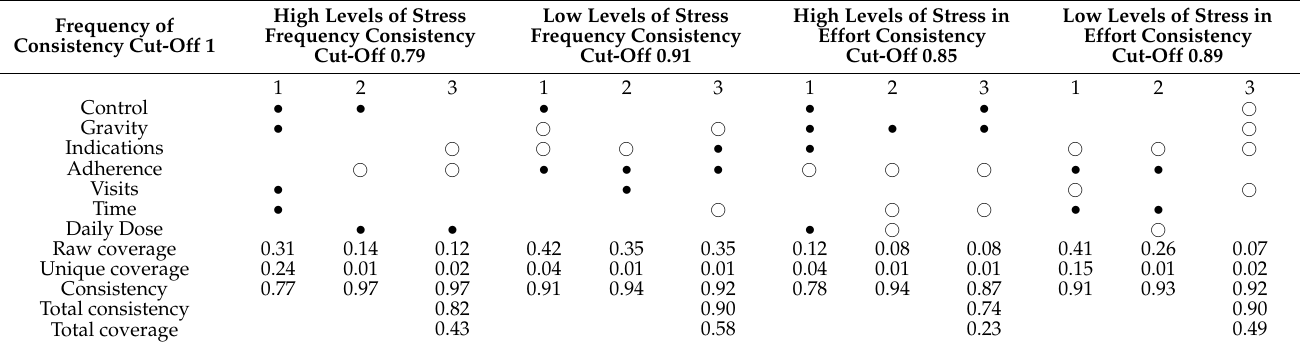
Table 5. Sufficiency analysis for high and low levels of stress in the perceived primary caregiver: medical variables (n =